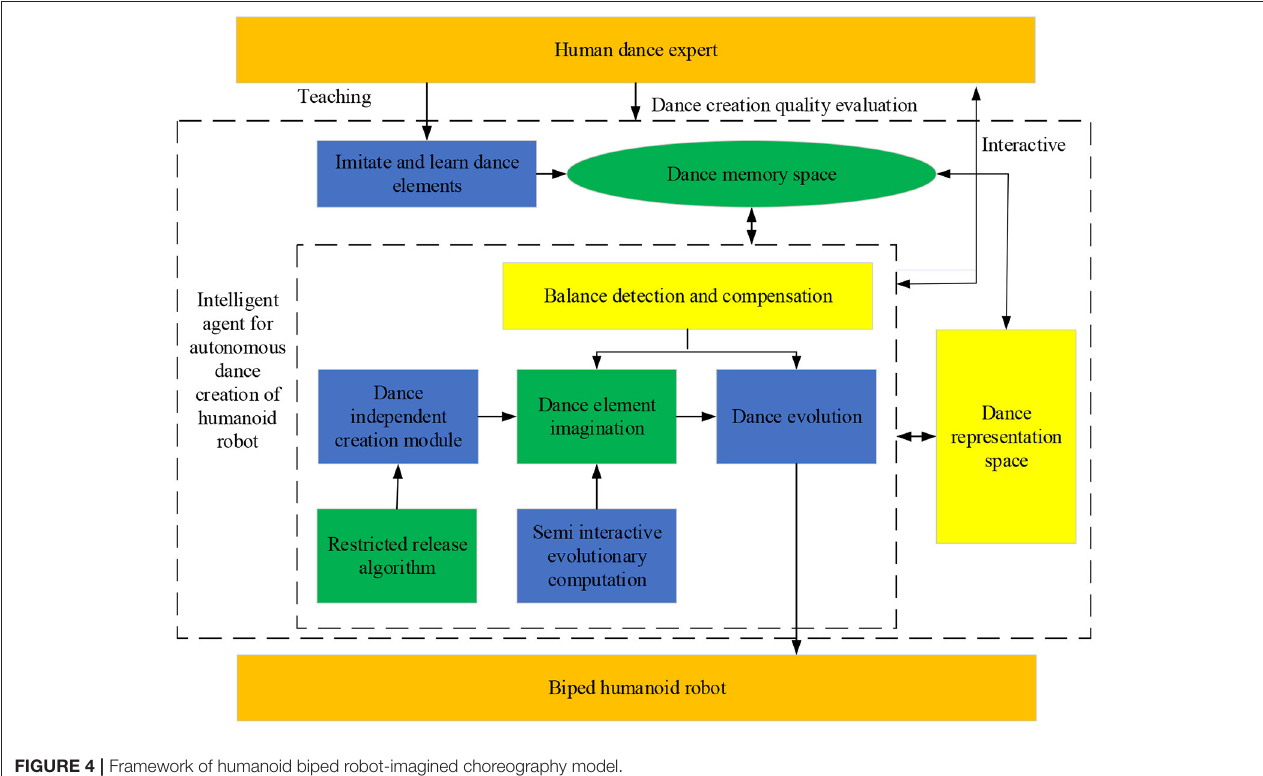
FIGURE 4 | Framework of humanoid biped robot-imagined choreography model.